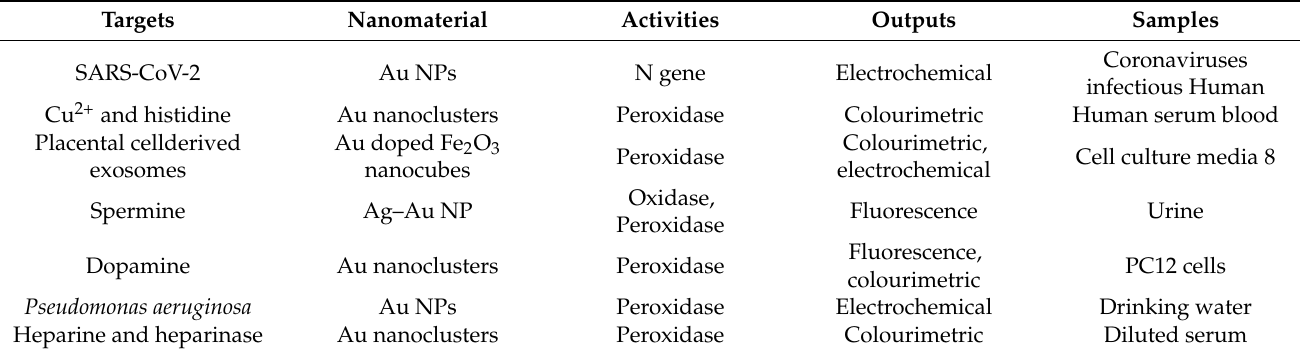
Table 2. Metal-based biosensors for biomedical applications [60].